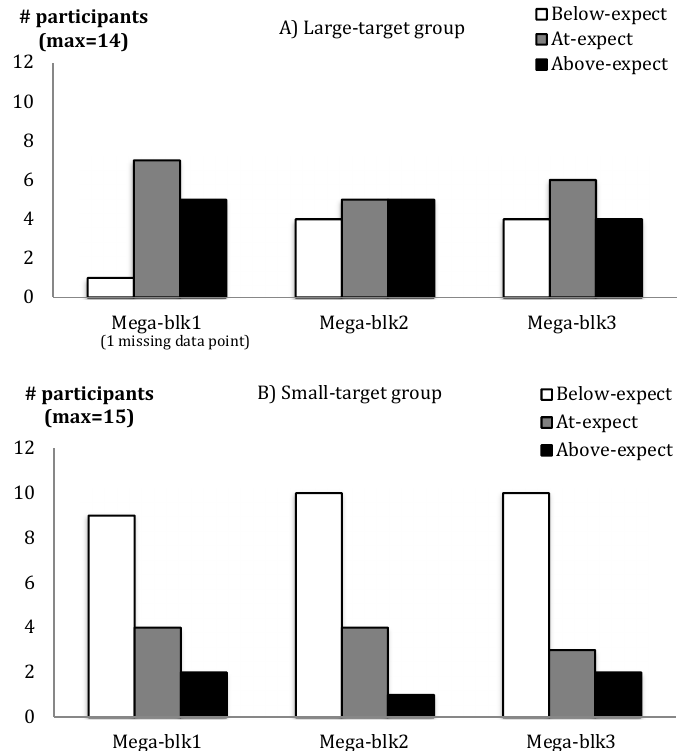
Figure 3. Number of participants performing below expectations (Below-expect), at expectations (At-expect), and above expectations (Above-expect) in the ( A ) Large-target and ( B ) Small-target groups as a function of Mega-blocks (Mega-blk) of 30 trials across practice.